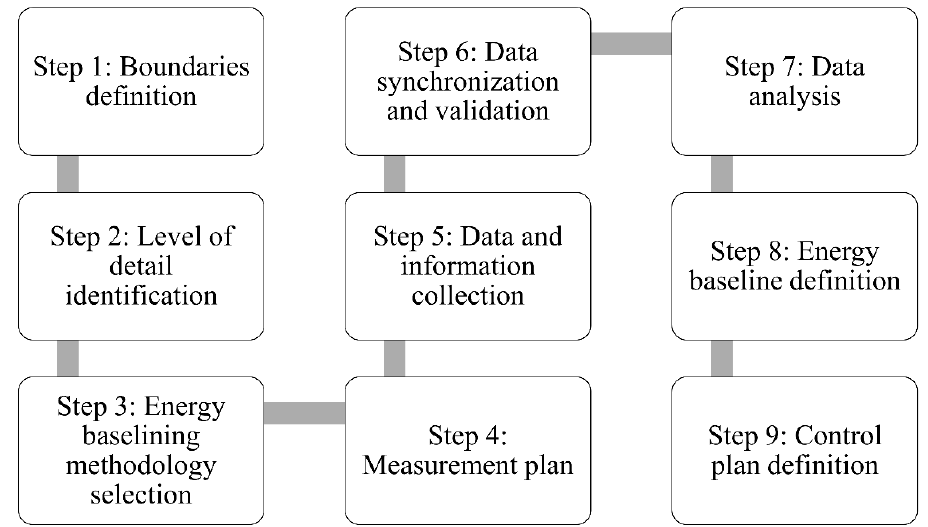
Figure 2. Conceptual map of the methodology developed for real time energy performance control. Such a process is iterative in nearly every step. Indeed, depending on the results of the specific step, it might be necessary to go back and change some of the assumptions or choices previously made.